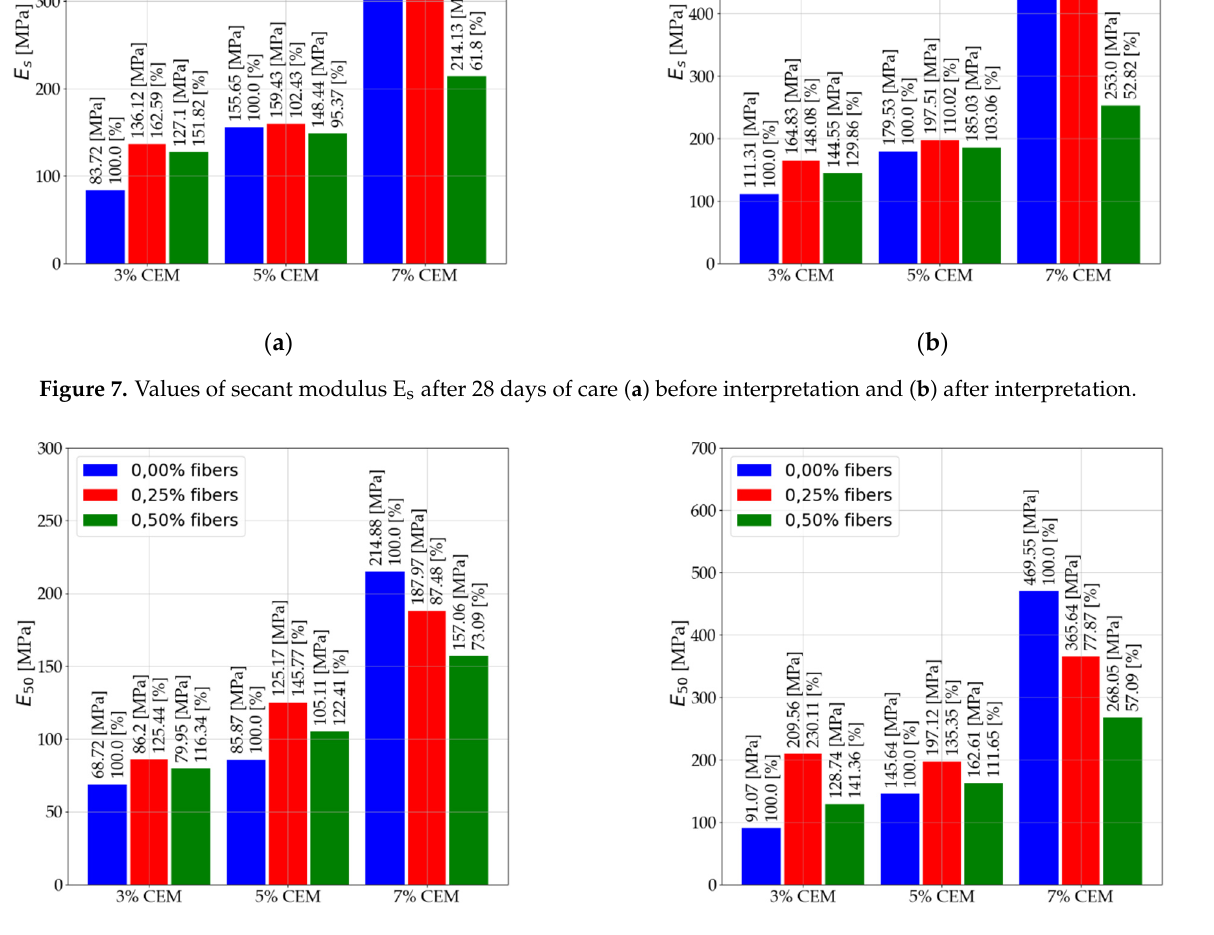
Figure 9. Values of secant modulus E (cid:2873)(cid:2868) after 28 days of care ( a ) before interpretation and ( b ) after interpretation.